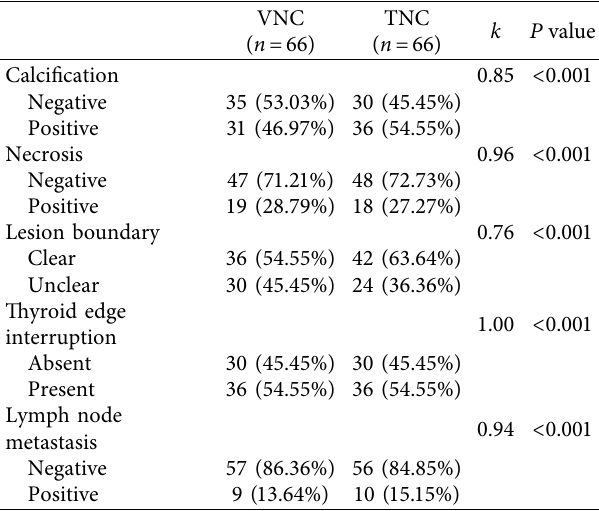
Table 2: Qualitative analysis of the characterization of thyroid lesions between VNC images and TNC images.